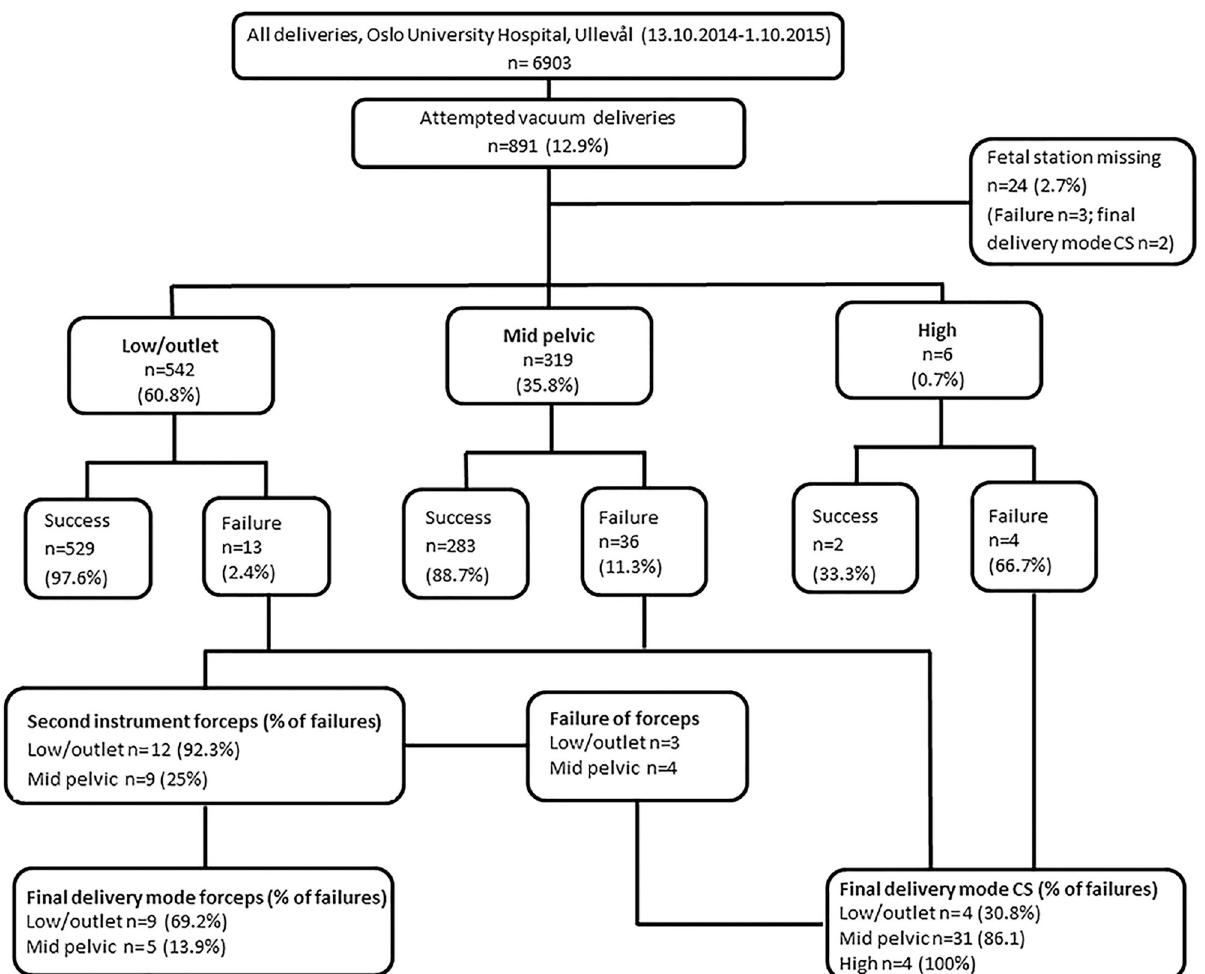
Fig 1. Study inclusion flow chart and outcome of attempted VE for the total cohort according to fetal station. CS, Cesarean section.